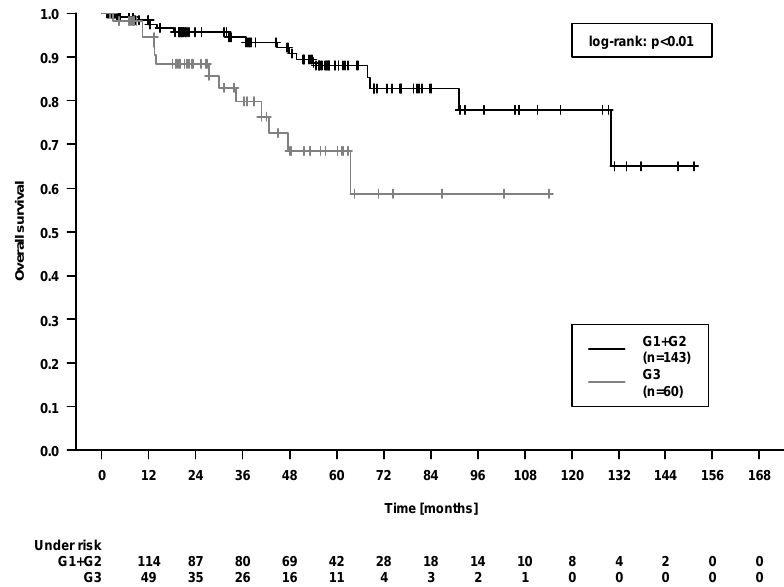
Figure 2. Overall survival in the whole patient cohort, comparison of patients with G1 + G2 tumors vs. patients with G3 tumors.